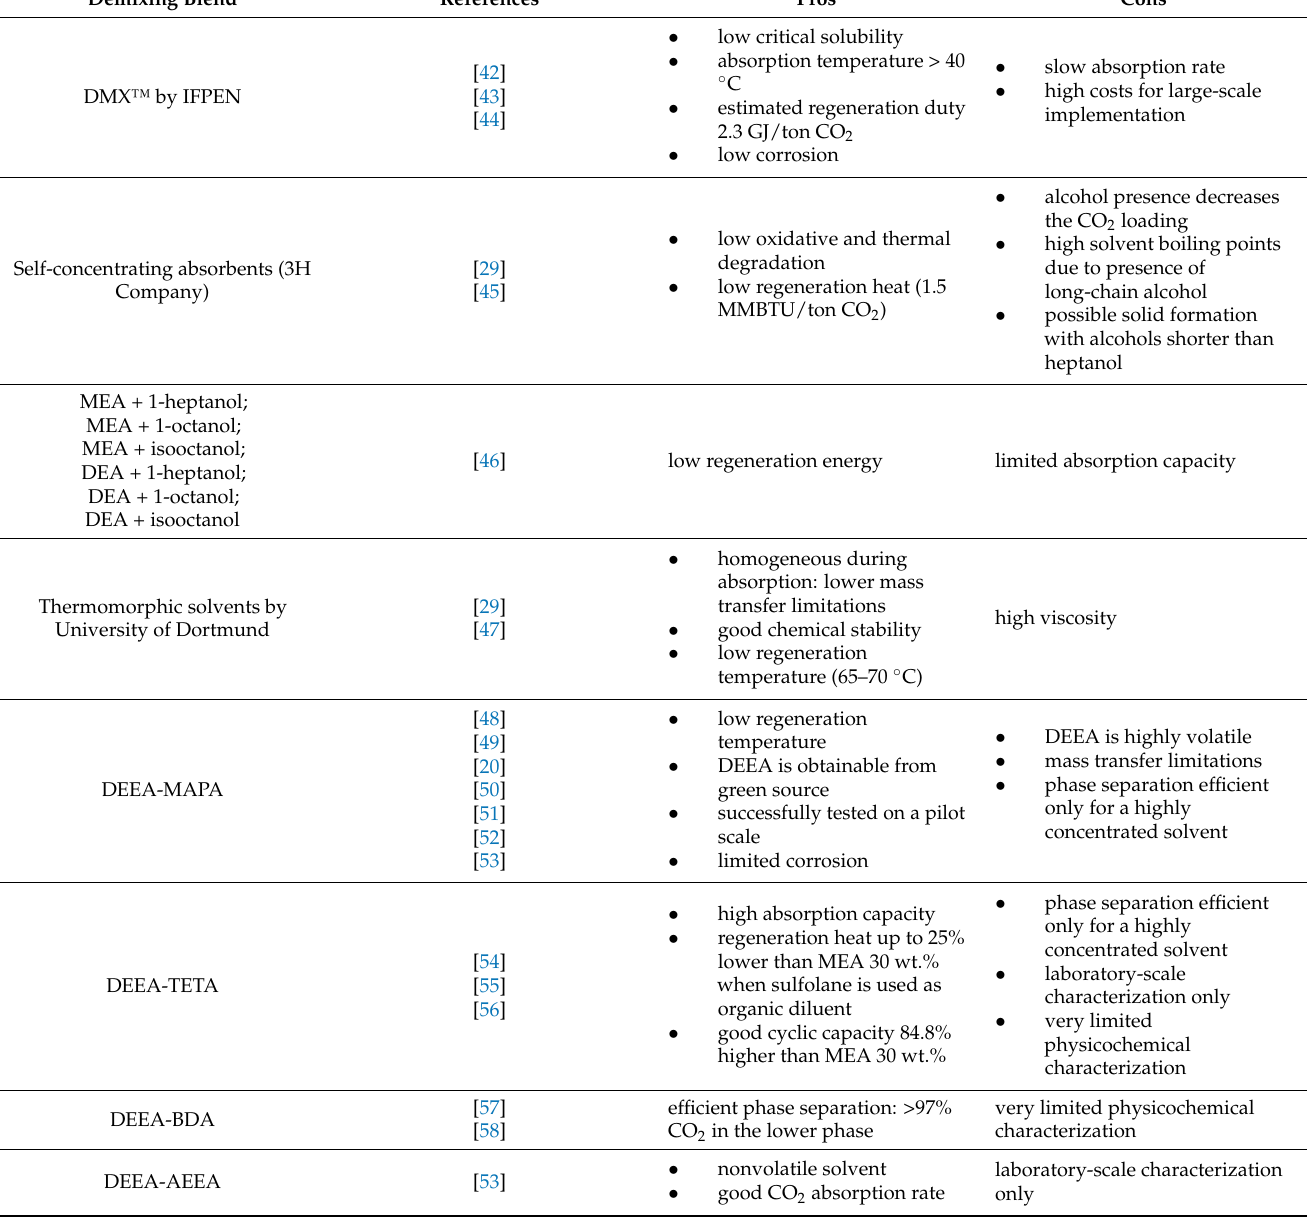
Table 1. Pros and cons of the biphasic blends studied in the literature for CO 2